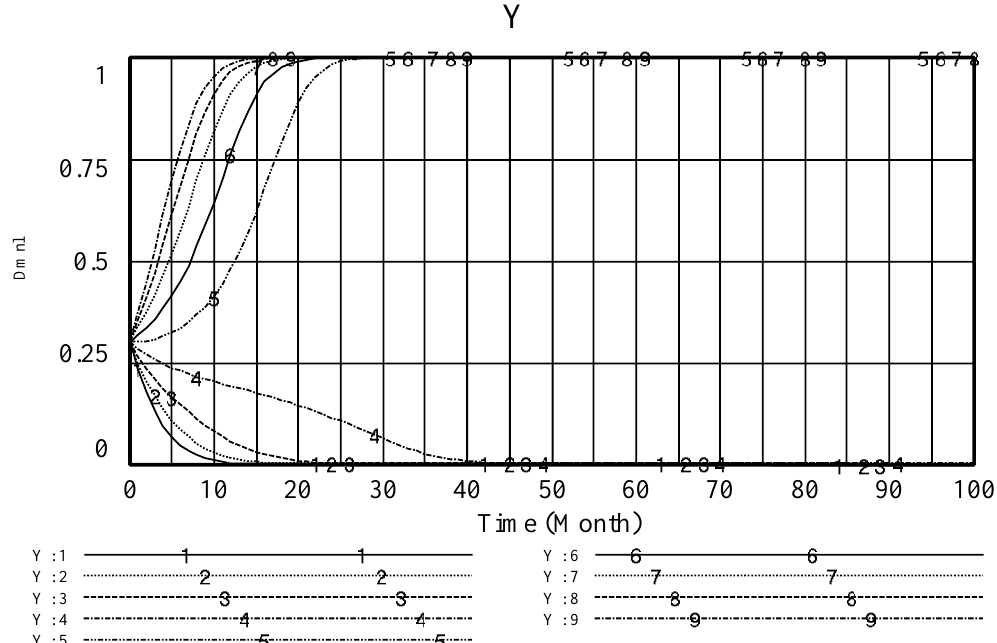
Figure 4. Simulation result of y when initial value of y is 0.3.